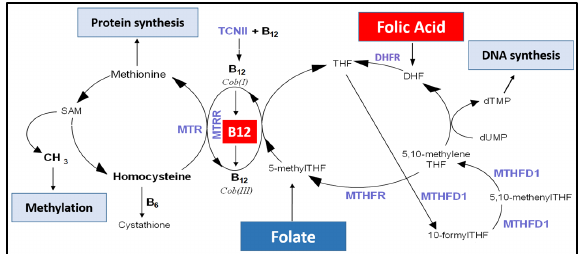
Figure 1. One-carbon metabolism: Overview of one-carbon metabolism. Folic acid (FA) is re- duced via dihydrofolate reductase (DHFR) to dihydrofolate (DHF) and tetrahydrofolate (THF). Methylenetetrahydrofolate dehydrogenase (MTHFD1) converts THF to intermediate metabolites 10-formyltetrahydrofolate (10-formylTHF), 5,10-methenyltetrahydrofolate (5,10-methenylTHF) and 5,10-methylenetetrahydrofolate (5,10-methyleneTHF). 5,10-methyleneTHF can be used in the con- version of deoxyuridine monophosphate (dUMP) to deoxythymidine monophosphate (dTMP) via thymidylate synthase (TS) or to 5-methylTHF via methylenetetrahydrofolate reductase (MTHFR). 5-methylTHF is used for homocysteine remethylation to methionine, which is reliant on vitamin B12 (B12)-dependent methionine synthase (MTR). Methionine is converted to S-adenosylmethionine (SAM), a methyl donor in methylation reactions, and sequentially to S-adenosylhomocysteine (SAH), a substrate of homocysteine remethylation. Adapted from Williamson et al., 2022